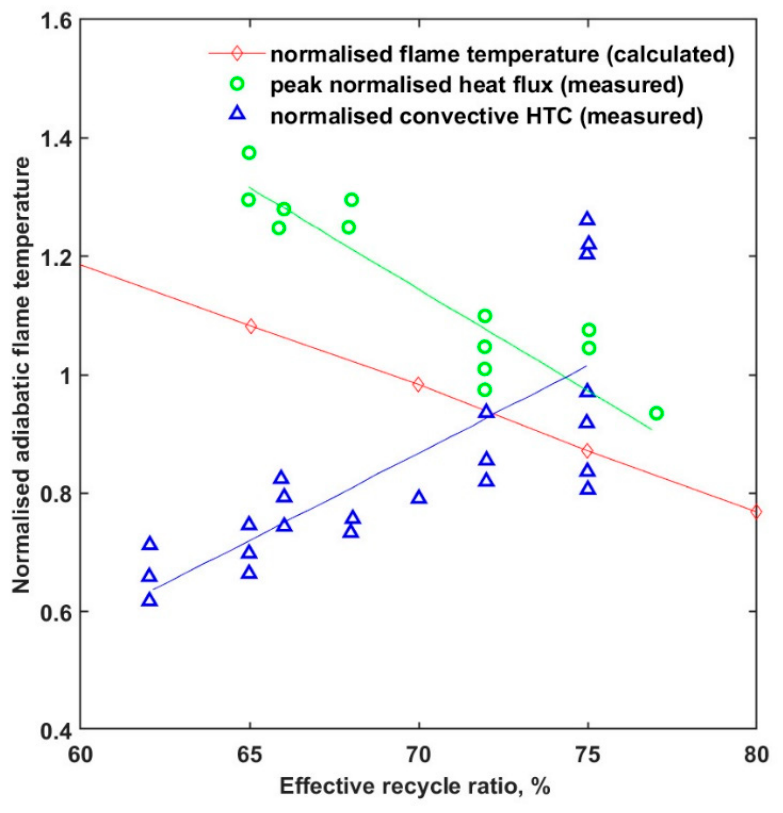
Figure 1. The effect of recycle ratio on various parameters characterizing the oxyfuel process. Adapted with permission from Ref. [39] Copyright © 2010 Elsevier Ltd.